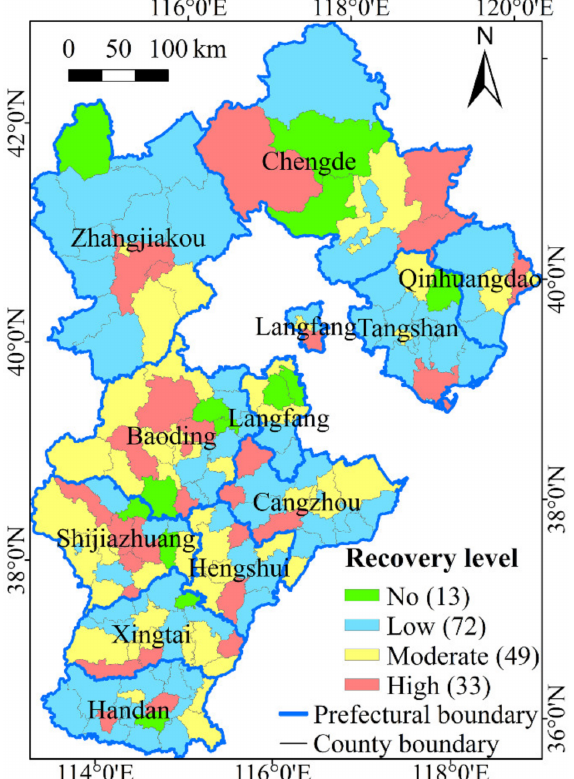
Figure 8. Spatial distribution map of the economic impact of the pandemic on county-level cities in Hebei Province during 2020 and